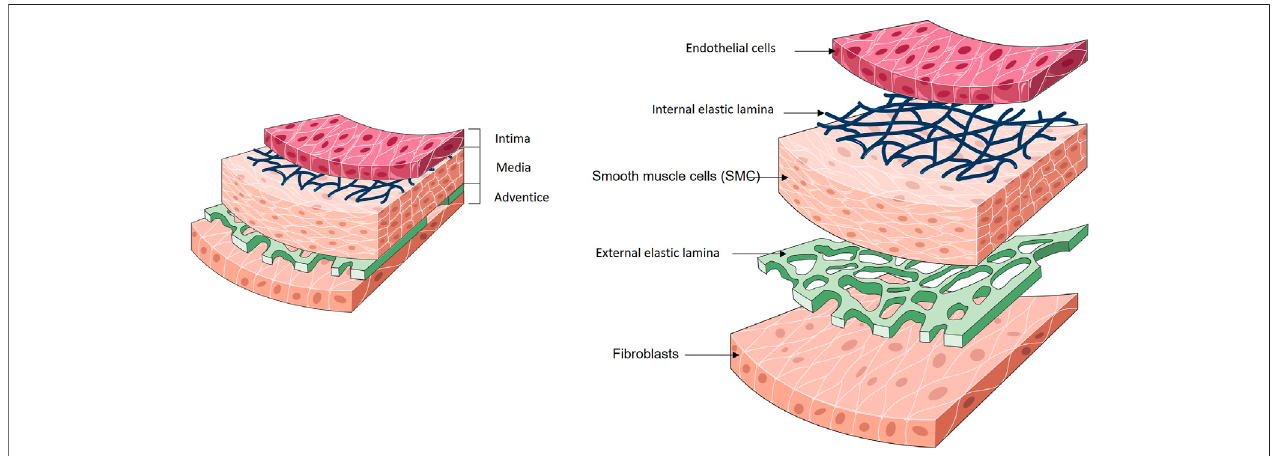
FIGURE 2 | General structure of a blood